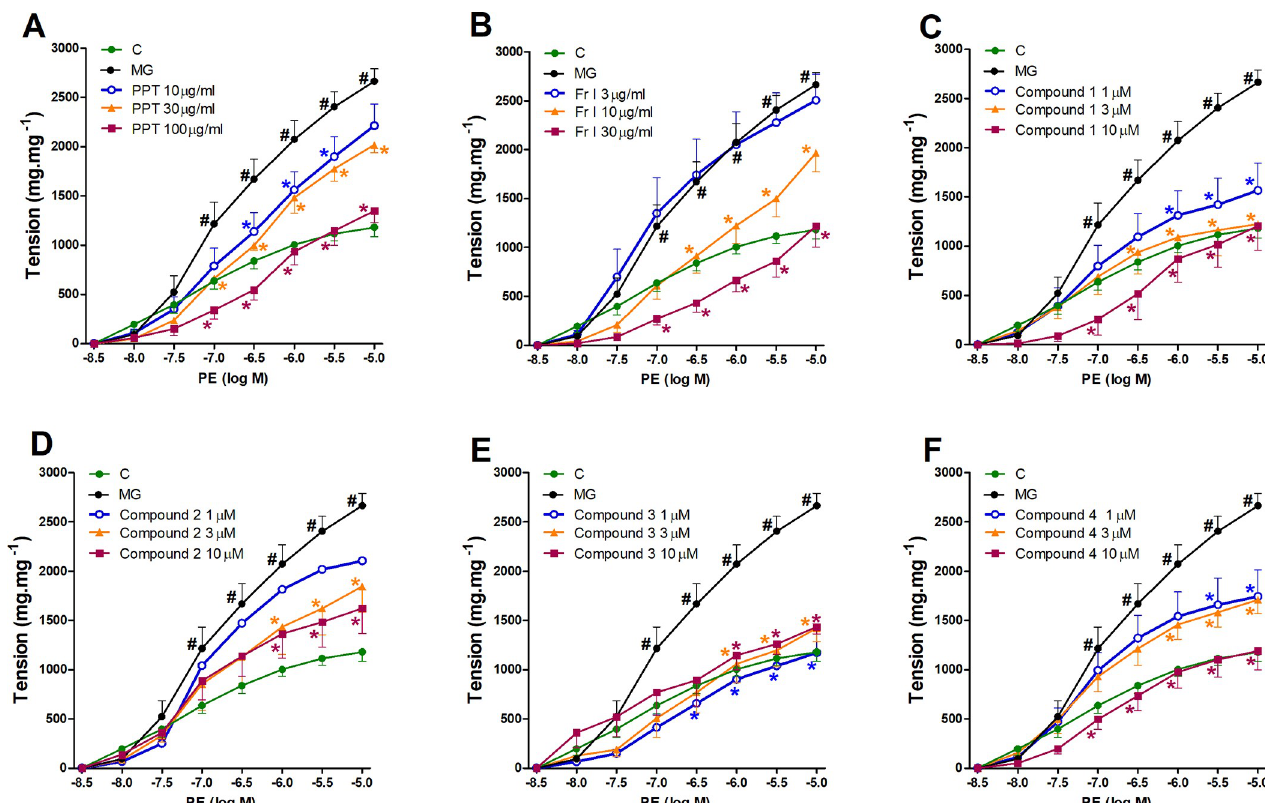
Fig 2. Effect of one hour incubation of different concentrations of PPT (A), Fr. I (B), and isolated compounds 1–4 (C-F) on the AGEs-induced aggravated responsiveness to PE of aortae isolated from normal rats. #P < 0.05, compared with the corresponding control values; � P < 0.05, compared with MG group; by Tow Way ANOVA and Bonferroni post hoc